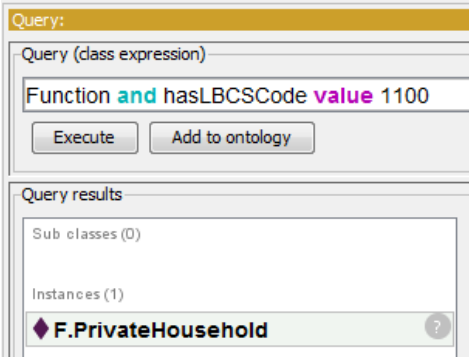
Figure 6. How to obtain OWL punned classes. An example of how to obtain the OWL entity (punned class) of a LBCS concept from its numerical code and dimension.